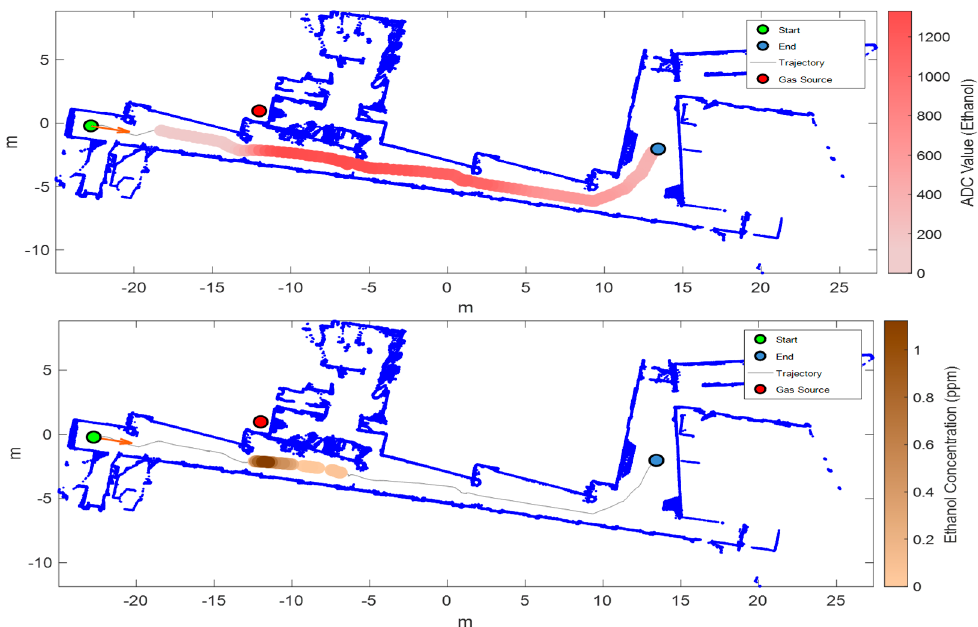
Figure 11. Results of exploration with an ethanol gas source inside a closed room and HVAC turned on (Scenario IV). Top: map of the arena (built by the robot) and mean sensor array response overlaid on the robot trajectory; bottom: map of the arena (built by the robot) and PID response overlaid on the robot trajectory.